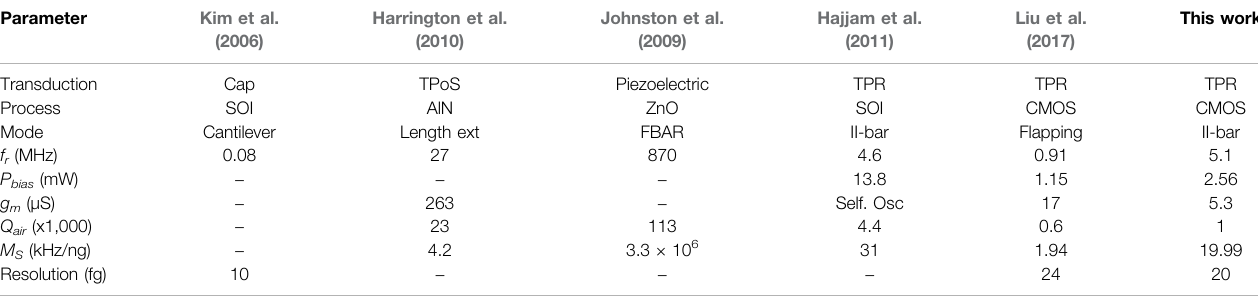
TABLE 3 | Performance comparison with prior works for mass sensing.